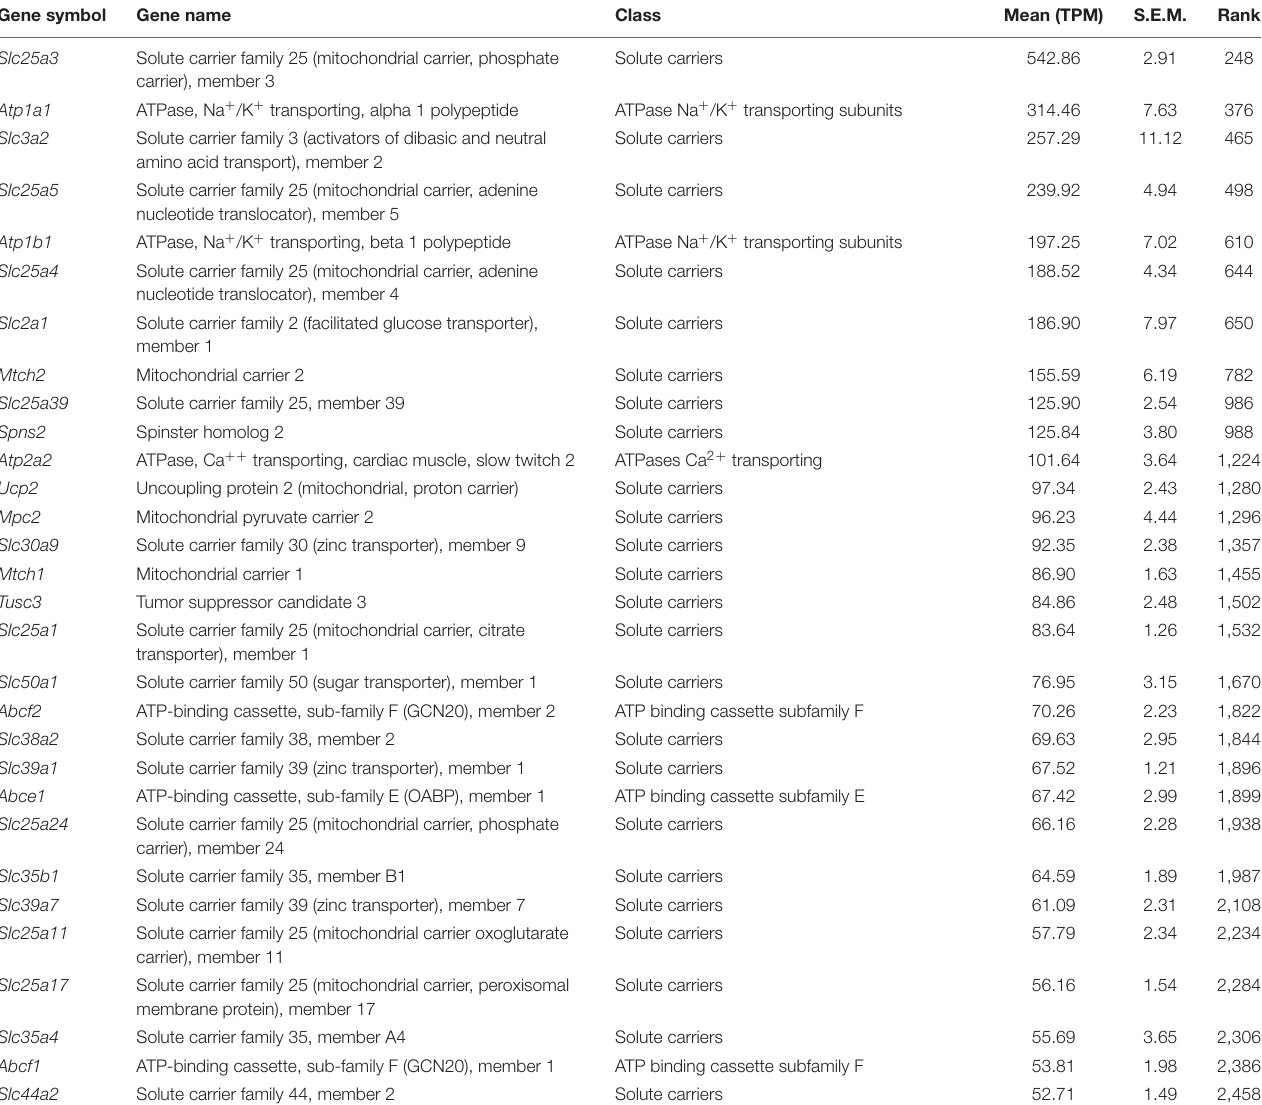
TABLE 3 | Top 30 transporters (see the full transporter list in Supplementary Table 1